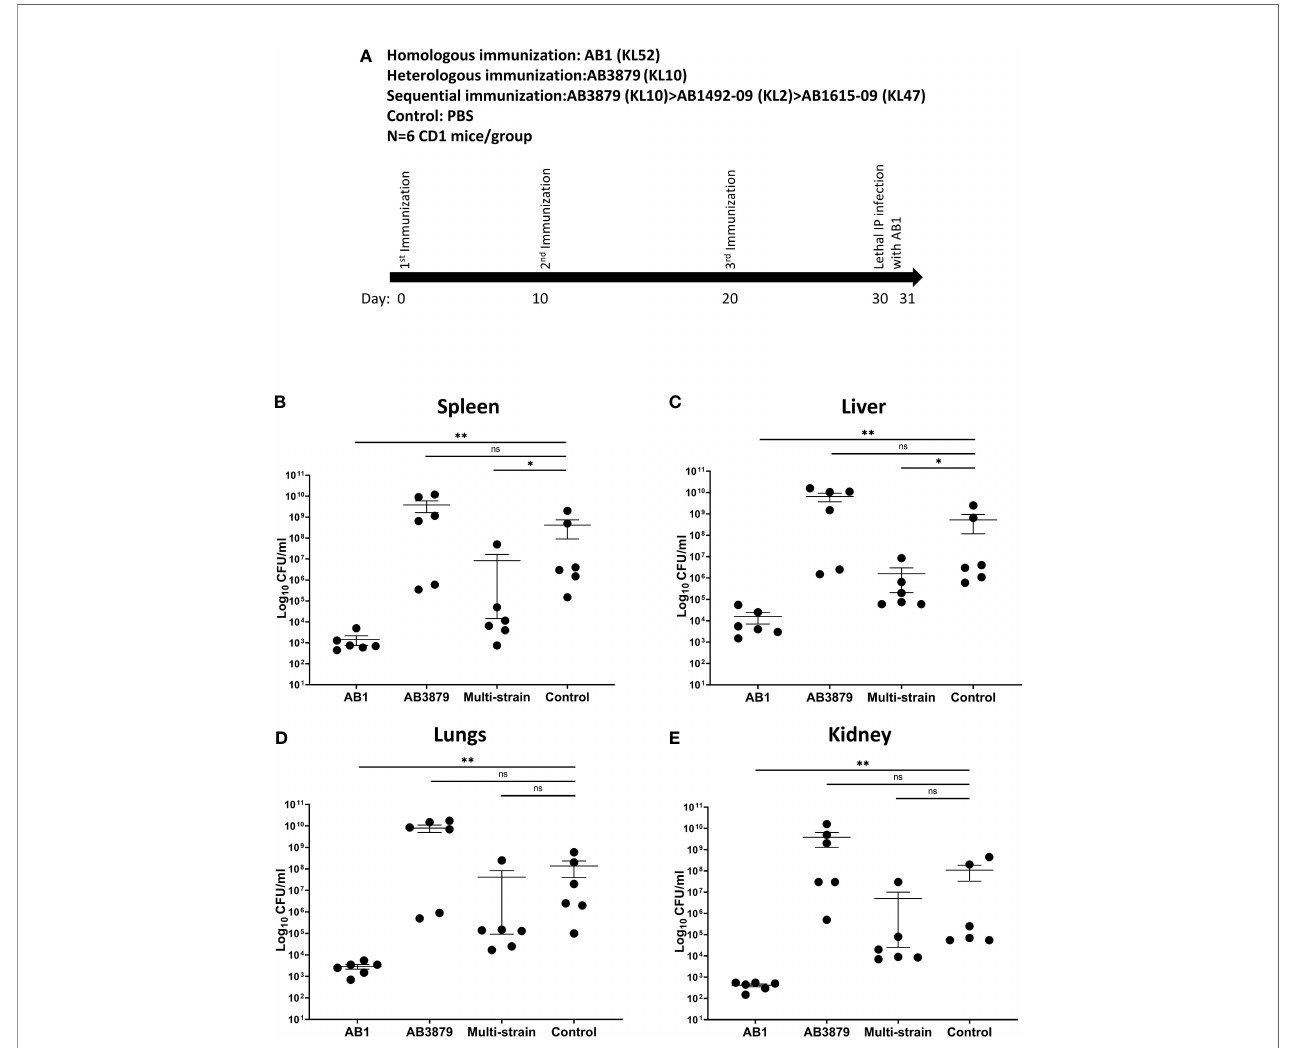
FIGURE 9 | Bacterial load in the spleen, liver, lungs and kidneys from mice following lethal challenge with heterologous AB1 isolates. (A) CD1 mice were immunized three times with 10 6 CFU of either AB3879, AB1, sequentially with AB3879, AB1492-09 & AB1615-09, or PBS followed by IP infection with 6.0 x 10 9 CFU/mouse of AB1 isolate in a lethal bacteremia model of infection. The bacterial burden in the (B) spleen, (C) liver, (D) lungs and (E) kidney were determined 24 hpi. Dot plots represent individual values with lines indicating the mean and the error bars indicate standard deviations (SDs) (n = 6/group) Mann-Whitney U-test was used for statistical analysis *p-value < 0.05, **p-value < 0.01, ns: p-value=not signi fi